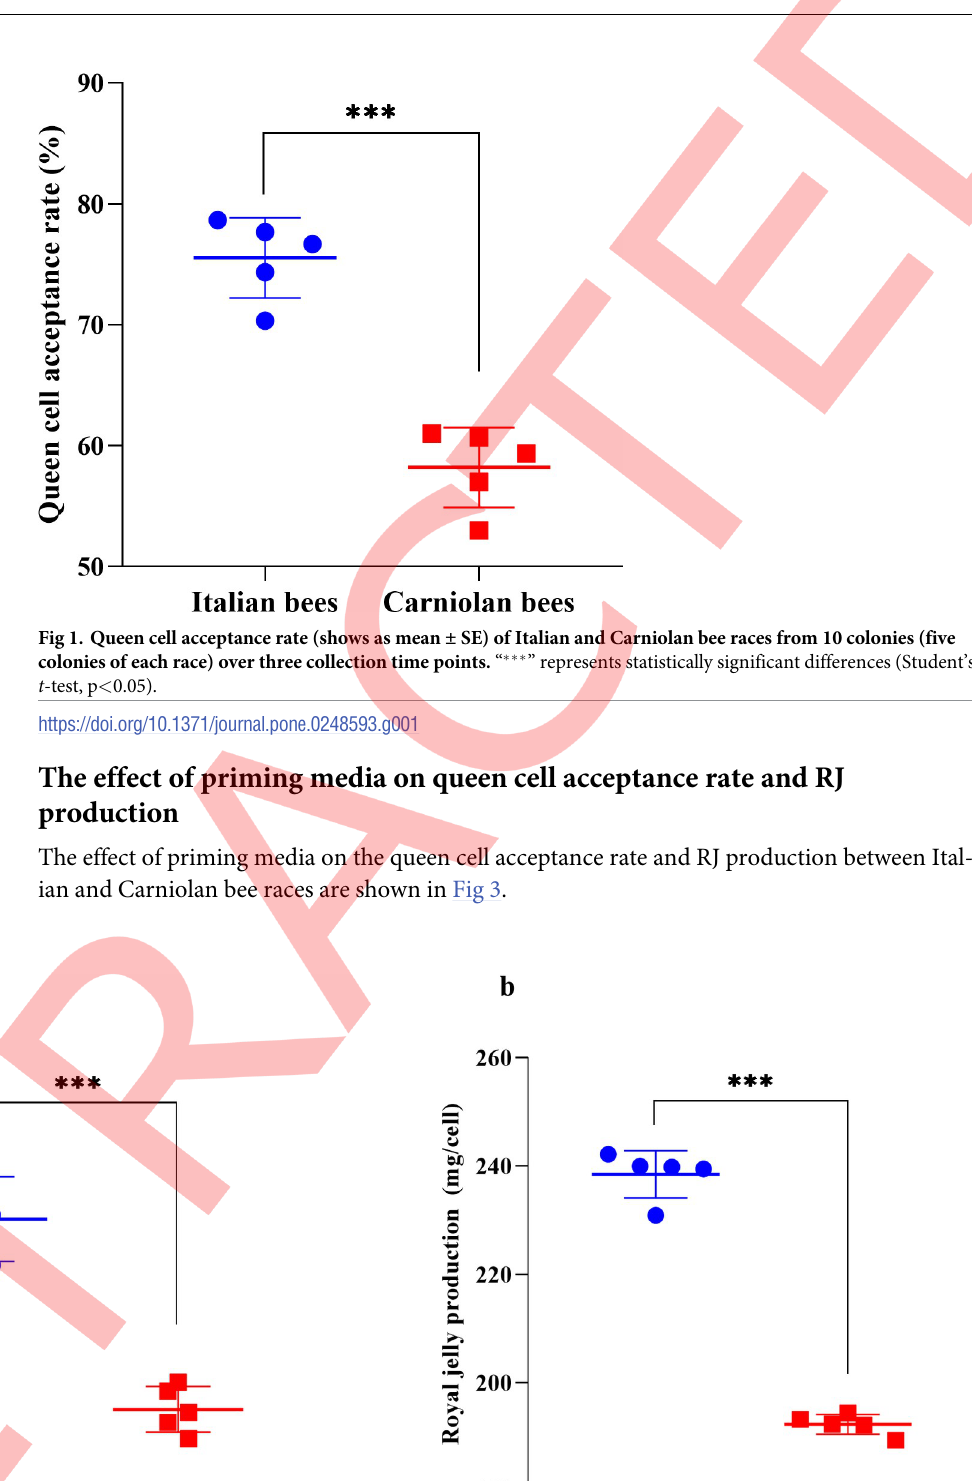
Fig 2. Mean weight (mean ± SE) of royal jelly for Italian and Carniolan lines around 72 hours after larval grafting (a) RJ production per colonies in grams after 72 h harvesting and (b) RJ production per cell cup in (mg) between both bee stocks. “ ��� ” represents statistically significant differences (Student’s t -test, p <